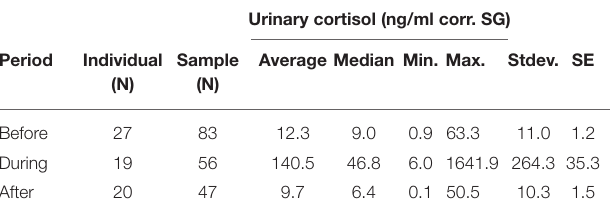
TABLE 1 | Urinary cortisol levels (ng/ml corr. SG) in wild chimpanzees during each sampling period before, during, and after the respiratory outbreak